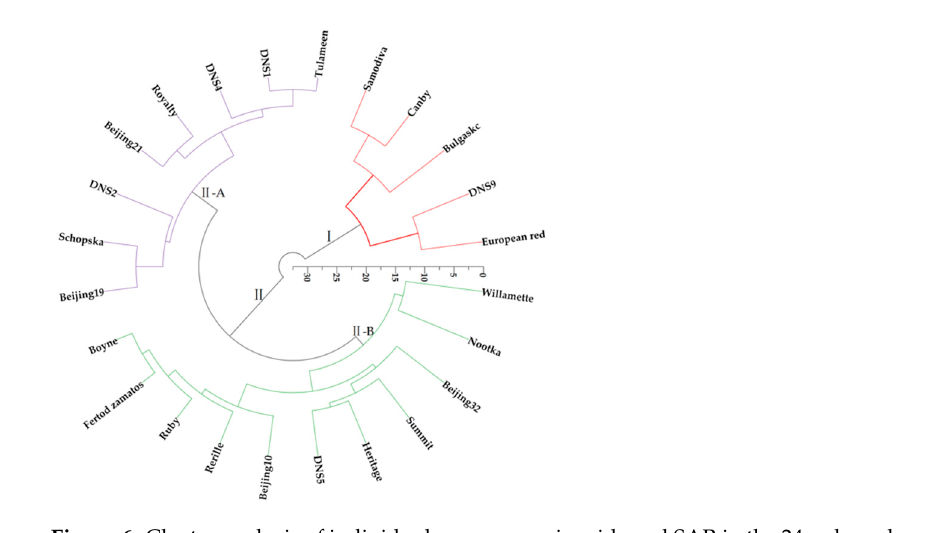
Figure 6. Cluster analysis of individual sugar, organic acids and SAR in the 24 red raspberry varie-